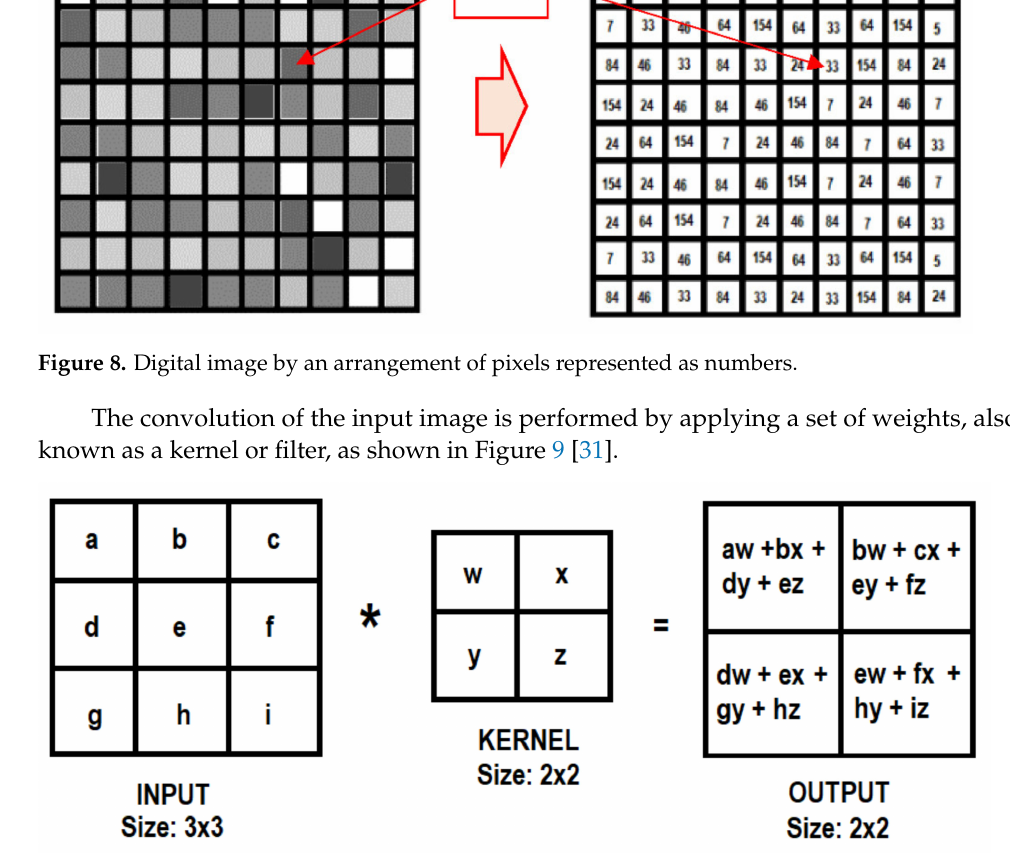
Figure 9. Convolution process of a part of an image by matrix multiplication. The symbol (*) means the convolution